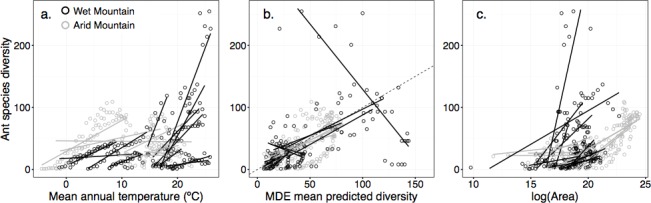
Scatterplots with regression lines for temperature, area, and MDE mean predictions with observed diversity showing wet and area mountains.Points represent elevational sites (black: wet mountains; gray: arid mountains) and lines are the regression lines for each study. Panels show the ant diversity predicted by (a) mean annual temperature, (b) mid-domain effect mean predicted diversity, and (c) log-transformed area. The dotted line in (b) represents the 1:1 relationship that would be expected with a perfect MDE fit.